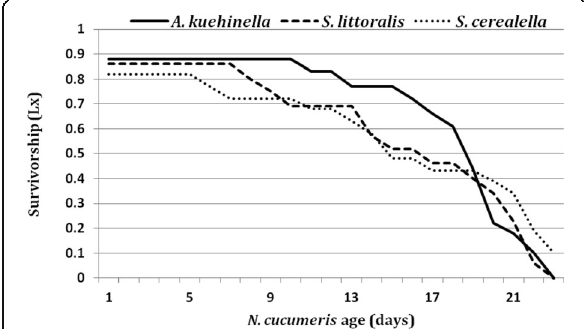
Fig. 2 Age-specific survivorship of Neoseiulus cucumeris fed eggs of Anagasta kuehniella , Spodoptera littoralis , and Sitotroga cerealella and incubated at 27 °C and 65% RH